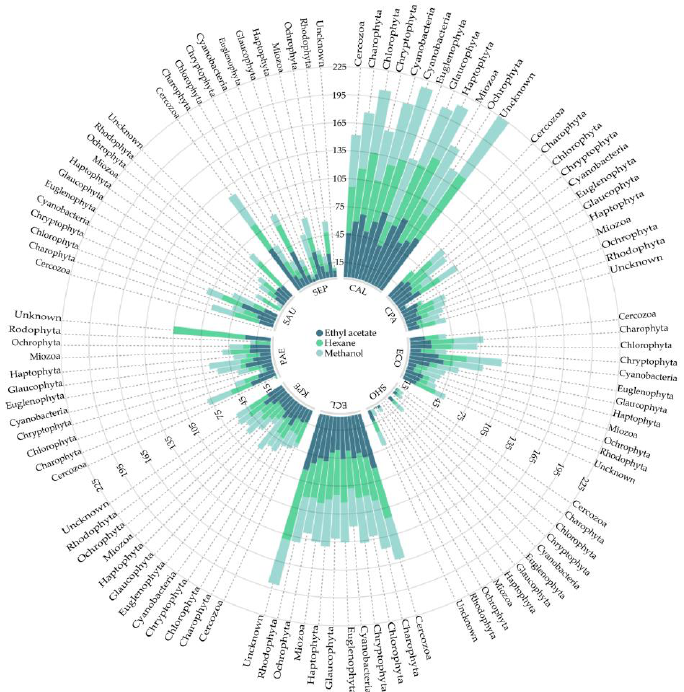
Figure 1. Circular dot plot representing the biofilm inhibition ratio (%) of each bacterium in relation to the solvent employed (ethyl acetate, hexane, and methanol), according to the microalgae and cyanobacteria phylum. CAL: C. albicans ; CPA: C. parapsilopsis ; ECO: E. coli ; SHO: S. hominis ; ECL: E. cloacae ; KPE: K. pneumoniae ; PAE: P. aeruginosa ; SAU: S. aureus ; SEP: S. epidermidis .